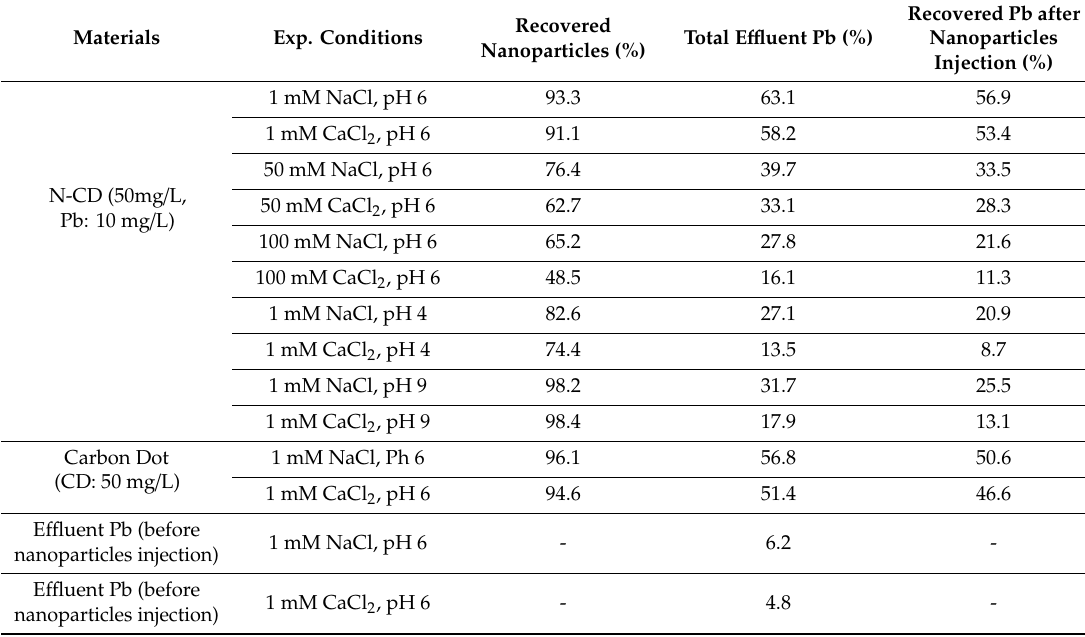
Table 2. N-CDs, CDs, and Pb recovered in column experiments at di ff erent condition (Standard Deviation (STD) <